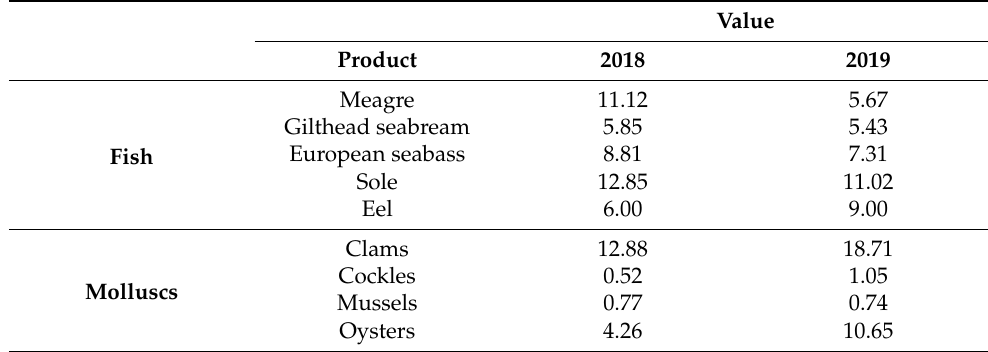
Table 1. Average national prices (EUR/kg) of Portuguese coastal systems’ aquaculture products for human consumption in 2018 and